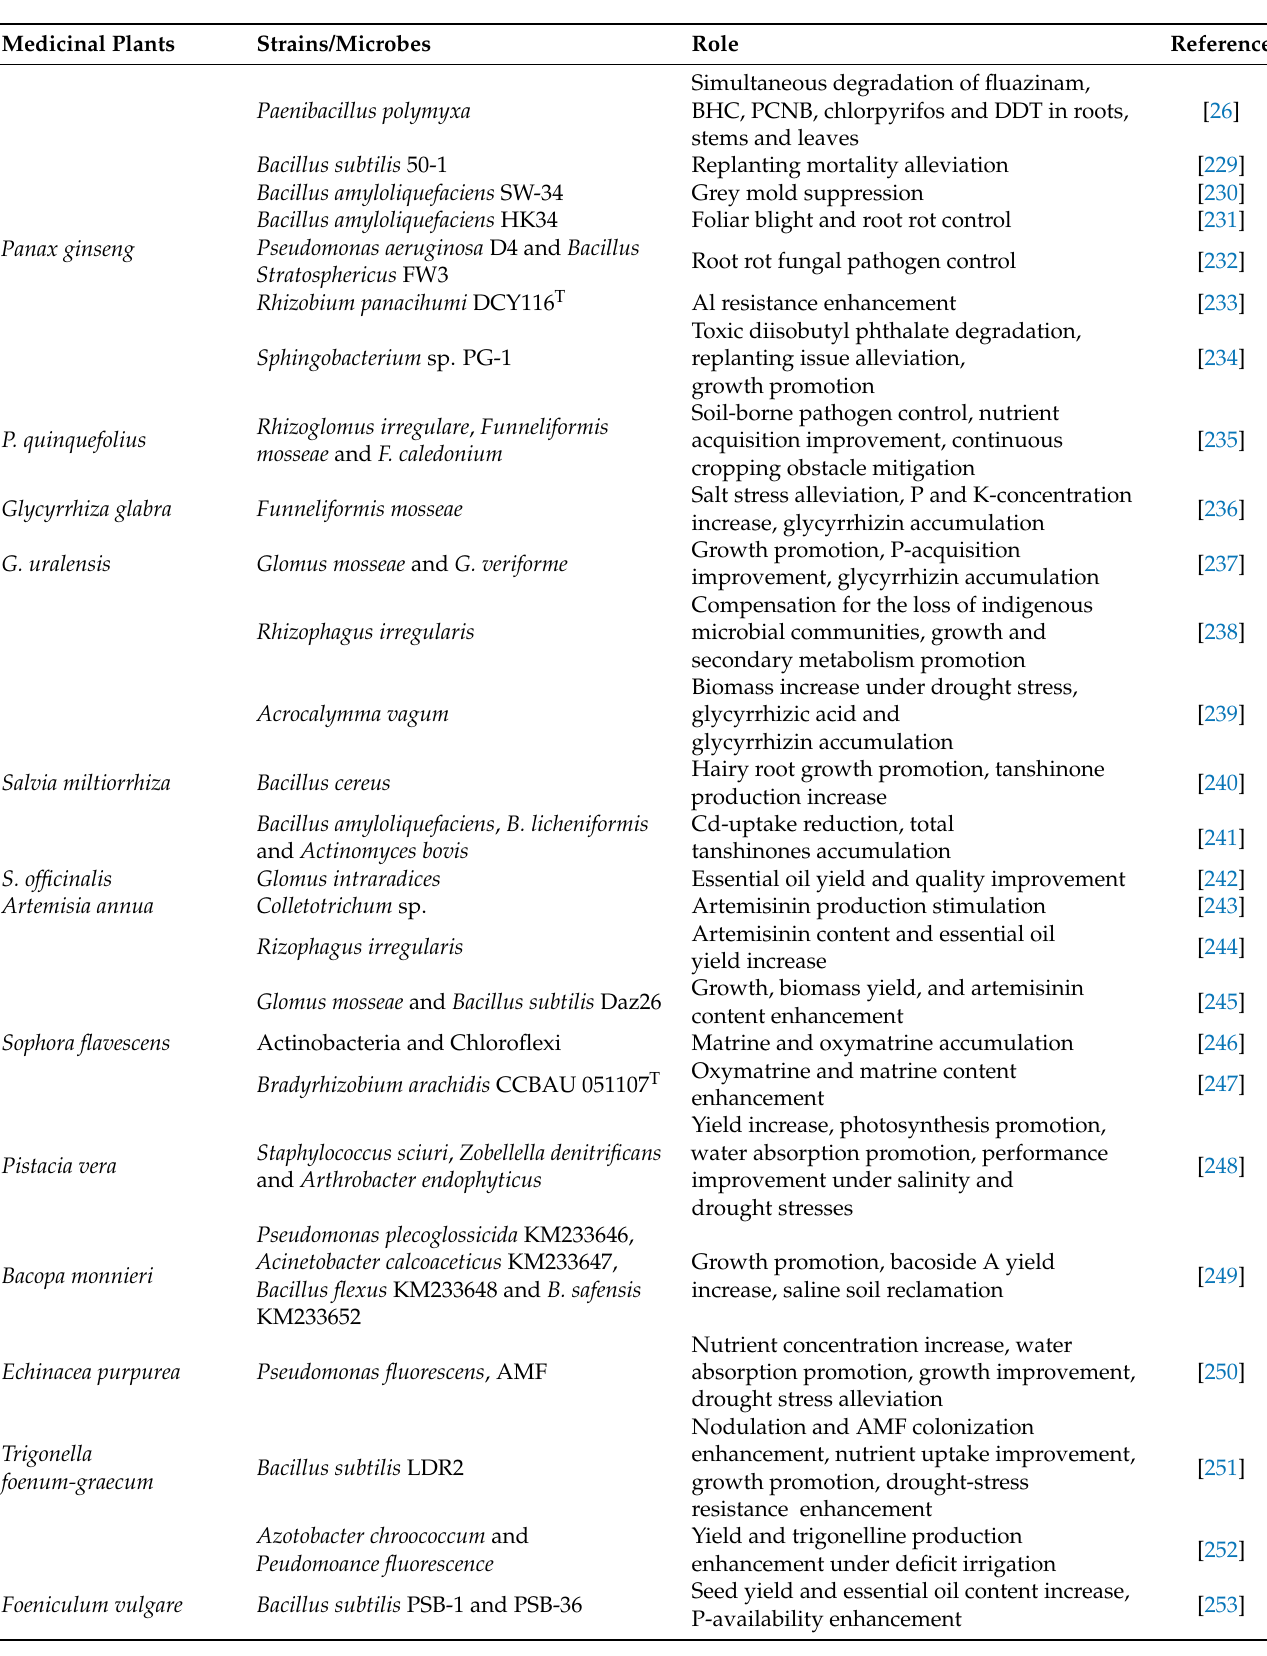
Table 2. Role of beneficial microorganisms on growth promotion and quality improvement of medicinal